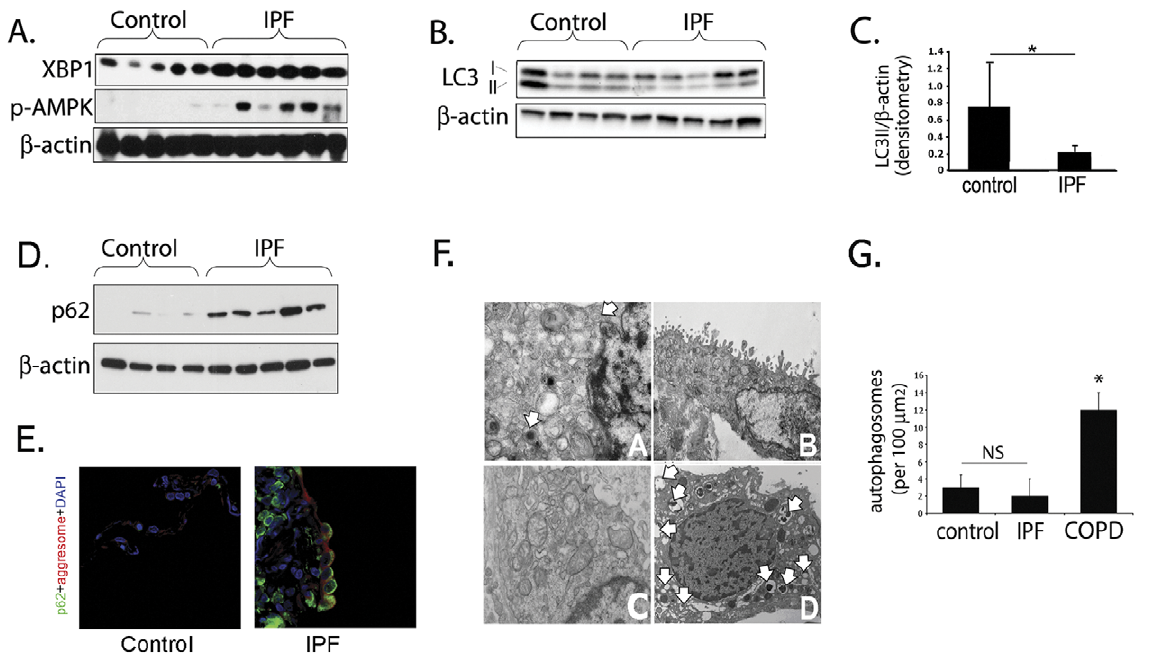
Figure 1. Autophagy is not increased in IPF. A) IPF whole lung homogenate demonstrates increased ER stress (elevated XBP1 expression) and increased phosphorylation of AMPK, factors which should drive autophagy. B) LC3-II (lower band) expression in IPF whole lung homogenate is decreased relative to control lung tissue C) Densitometry of Western blots demonstrating LC3-II level is lower in IPF than in control lung (*p=0.05). D) Increased p62 in IPF lung suggests decreased autophagy. E) Immunofluorescence confocal microscopy of control and IPF lung tissue for p62 (green), aggresome (red), DAPI (blue) demonstrates increased p62 expression and aggresomes. F) Representative electron microscopy images from IPF (panels A, B), control (Panel C), and COPD (panel D); white arrows indicate autophagosomes. G) Quantitation of autophagic vacuoles in control, IPF, and COPD lung by EM demonstrates significantly higher numbers in COPD (*p , 0.05 for IPF vs. COPD).